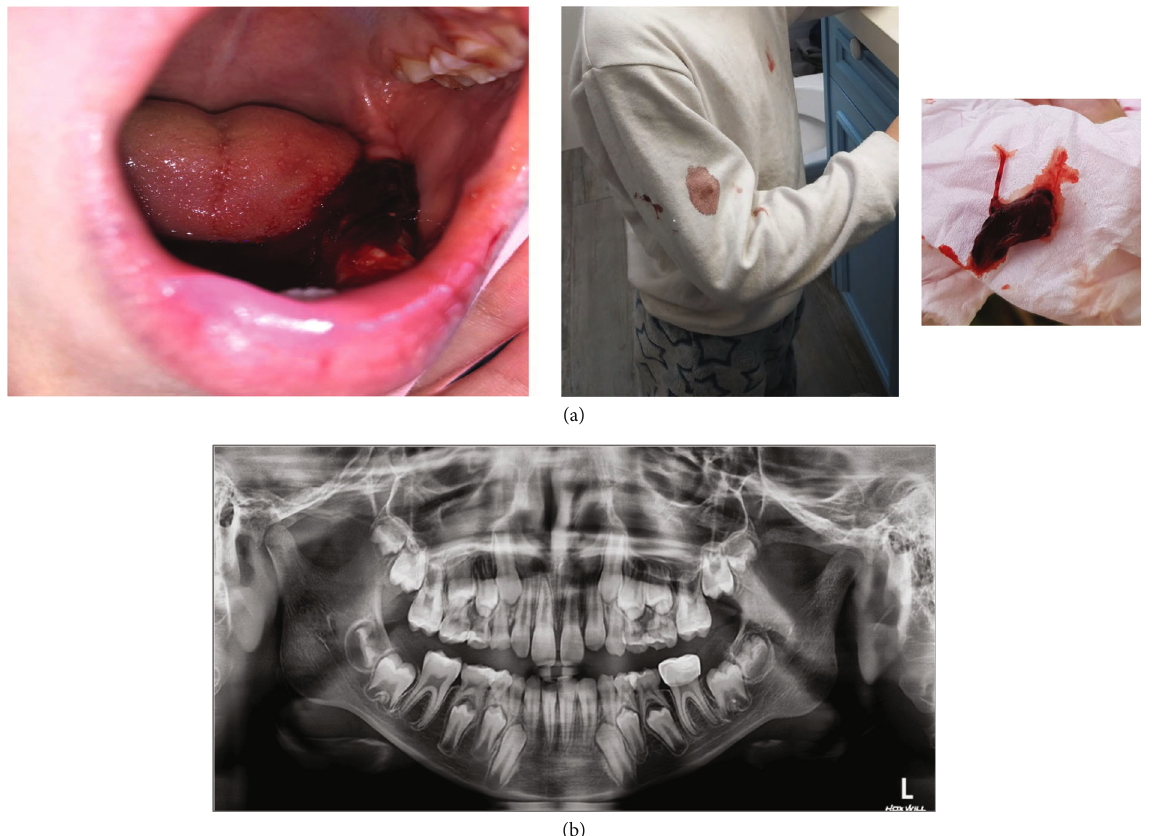
Figure 1: Patient case 3. (a) Bleeding and blood clot 36 hours after placement of SSC on his permanent lower left fi rst molar. (b) Six months postoperatively, no radiographic pathology associated with the SSC on a permanent lower